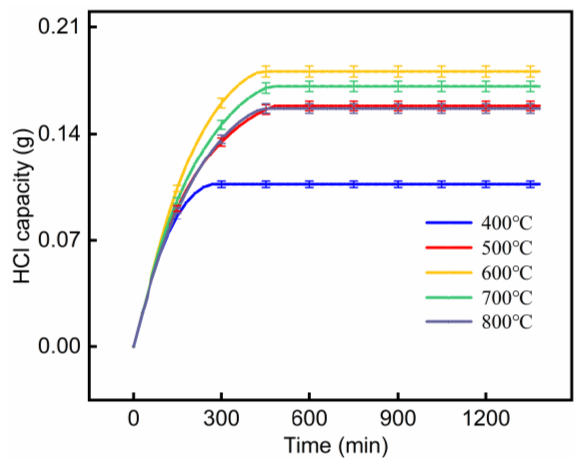
ff erent reaction